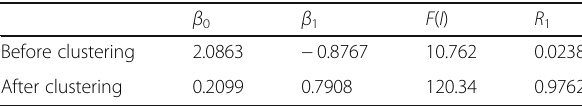
Table 2 Contrast of parameter estimate and testing